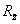
Confocal microscopy.The luminal surface of different types of described graft materials in this study was characterized by confocal laser scanning microscopy. The mean roughness depth Rz~ (μm) is given for each material. The scalebar represents 200 μm.